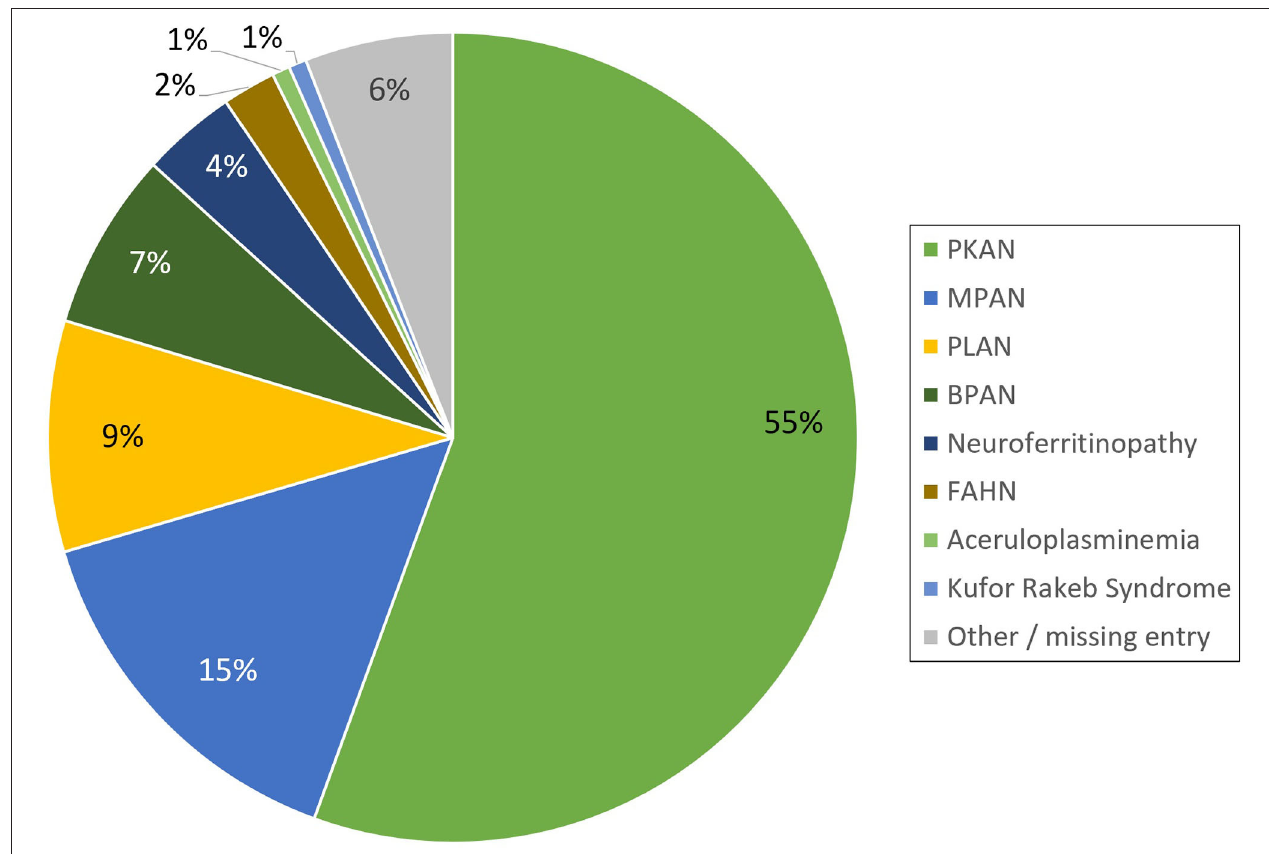
FIGURE 3 | Distribution of NBIA subtypes in the TIRCON patient registry (PKAN, Pantothenate Kinase-Associated Neurodegeneration; MPAN, Mitochondrial-membrane Protein-Associated Neurodegeneration; PLAN, PLA2G6 -Associated Neurodegeneration; BPAN, Beta-propeller Protein-Associated Neurodegeneration; FAHN, Fatty Acid Hydroxylase-Associated